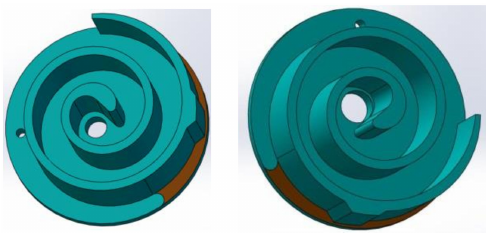
Figure 4. Maximum opening range of air